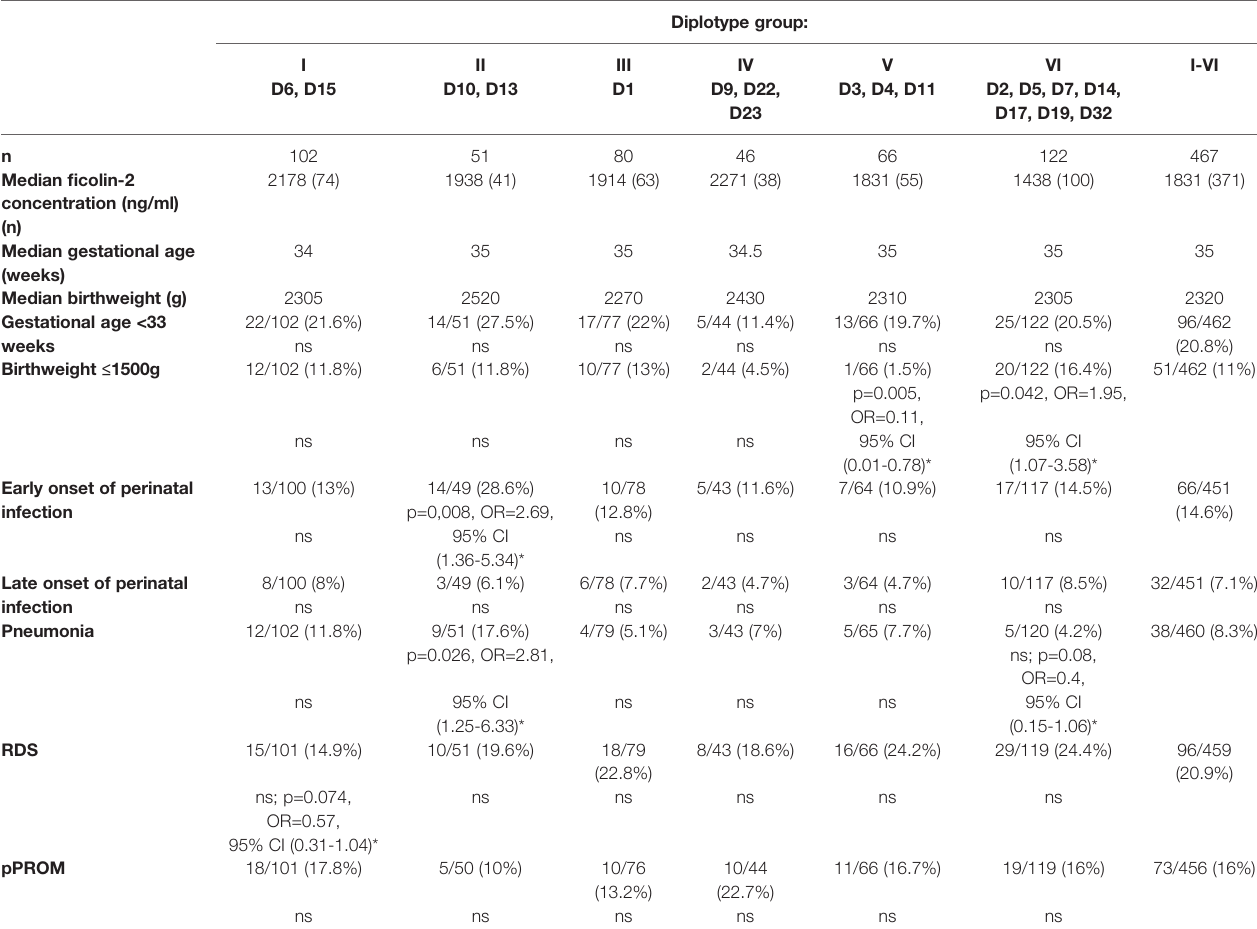
TABLE 6 | Associations of the FCN2 gene 3 ’ UTR diplotypes with adverse effects of prematurity.